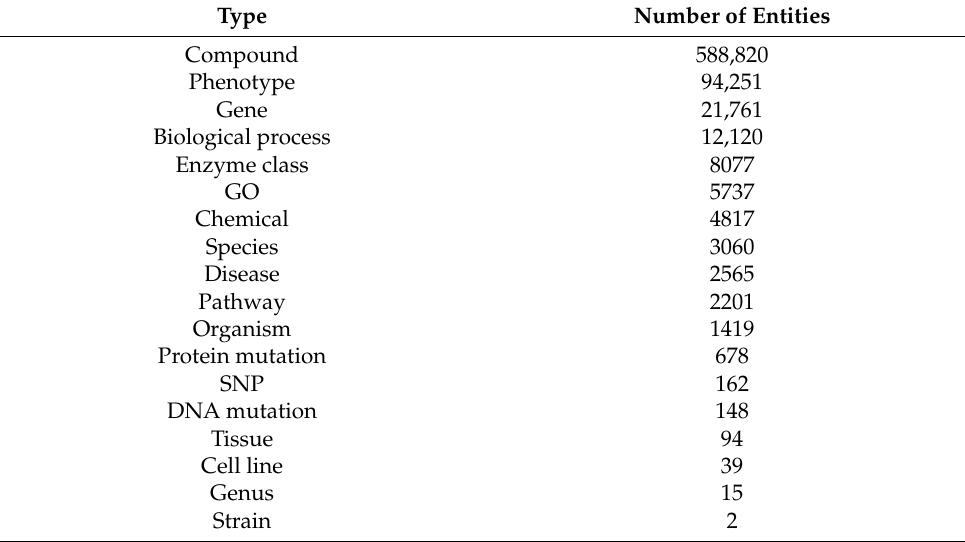
Table 6. Descriptive statistics of the merged